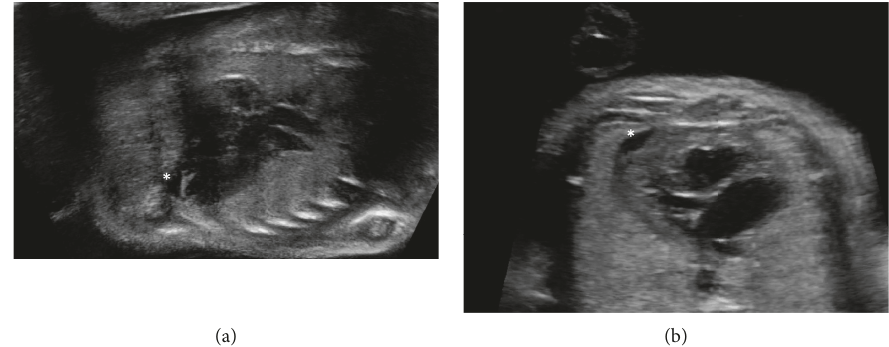
Figure 1: Fetal pericardial effusions. Fetal Twin A (a) and fetal Twin B (b) showing similar small apical pericardial effusions ( ∗ ).